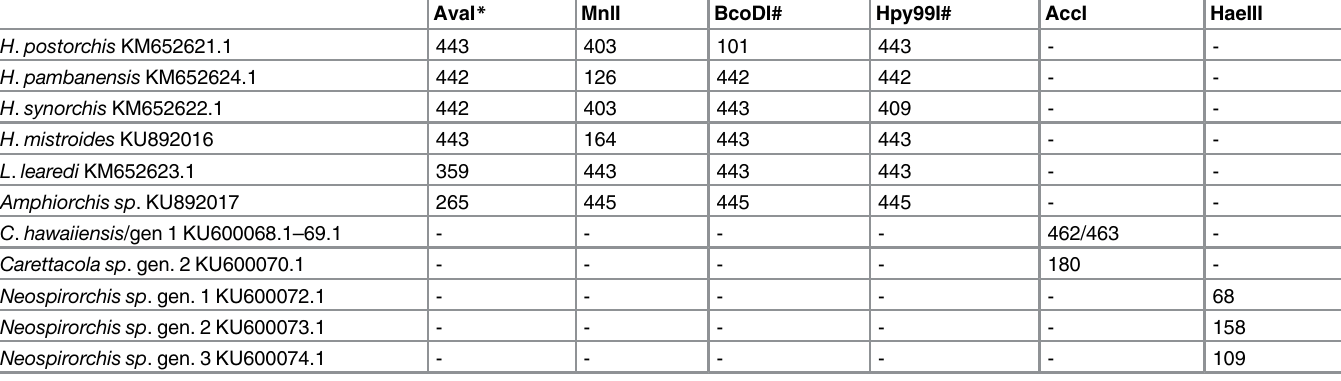
Table 2. Restriction enzymes used to identify each species/genotype following amplification with relevant primer pairs, with predicted 5 ’ fragment sizes. AvaI * MnlI BcoDI# Hpy99I# AccI